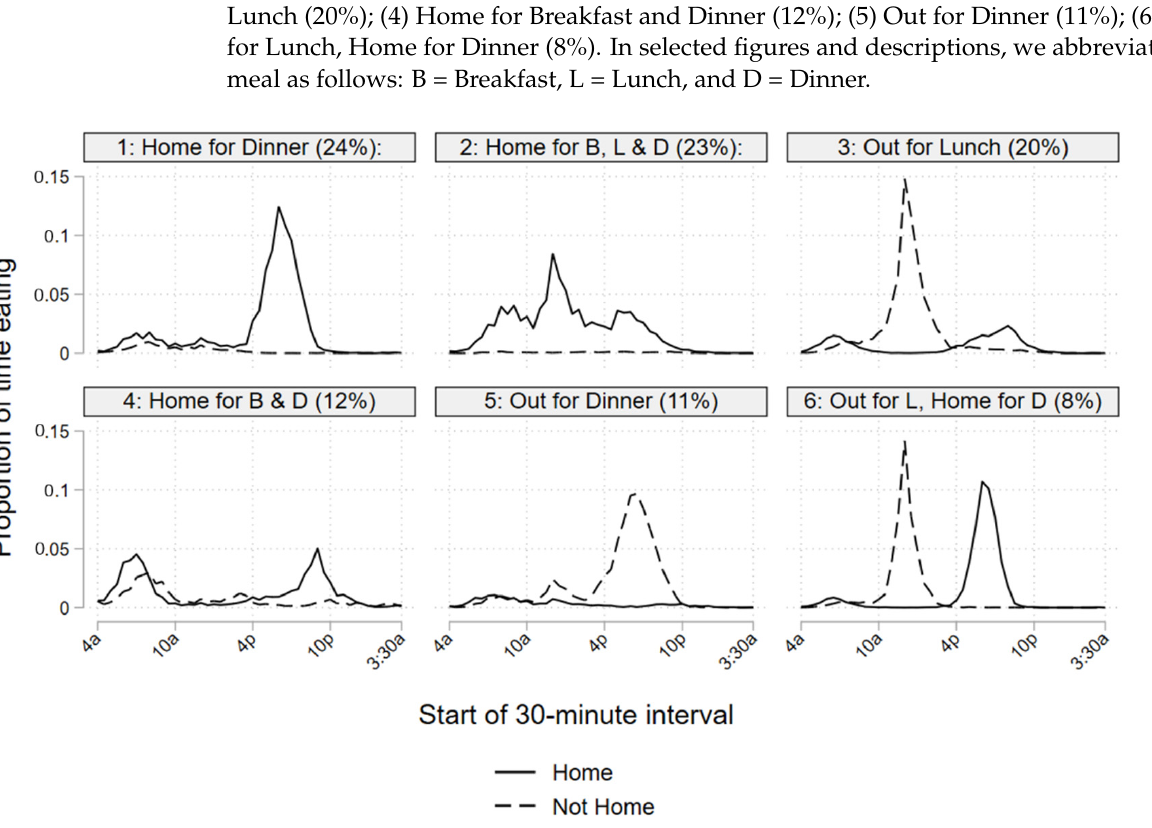
Figure 4. Time spent in primary and second eating by interval and location (as proportion of all eating).